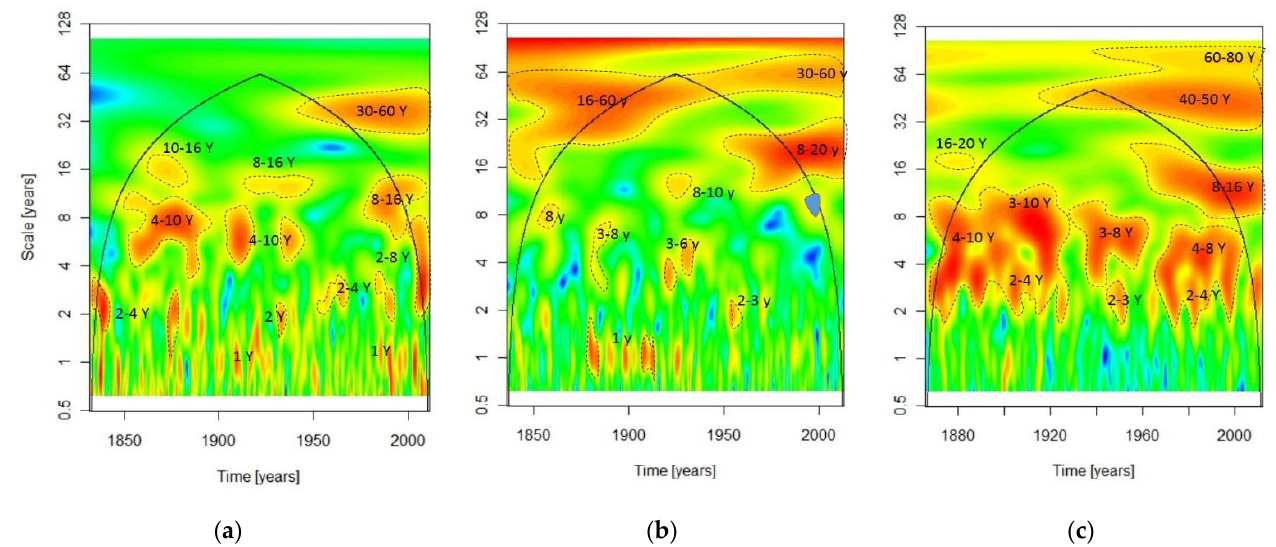
Figure 12. Local spectra of continuous wavelet analysis of climate indices: ( a ) NAO, ( b ) SOI, and ( c ) WMOI. Table 4. Global summary of changes identified by continuous wavelet analysis in the main climate indices.